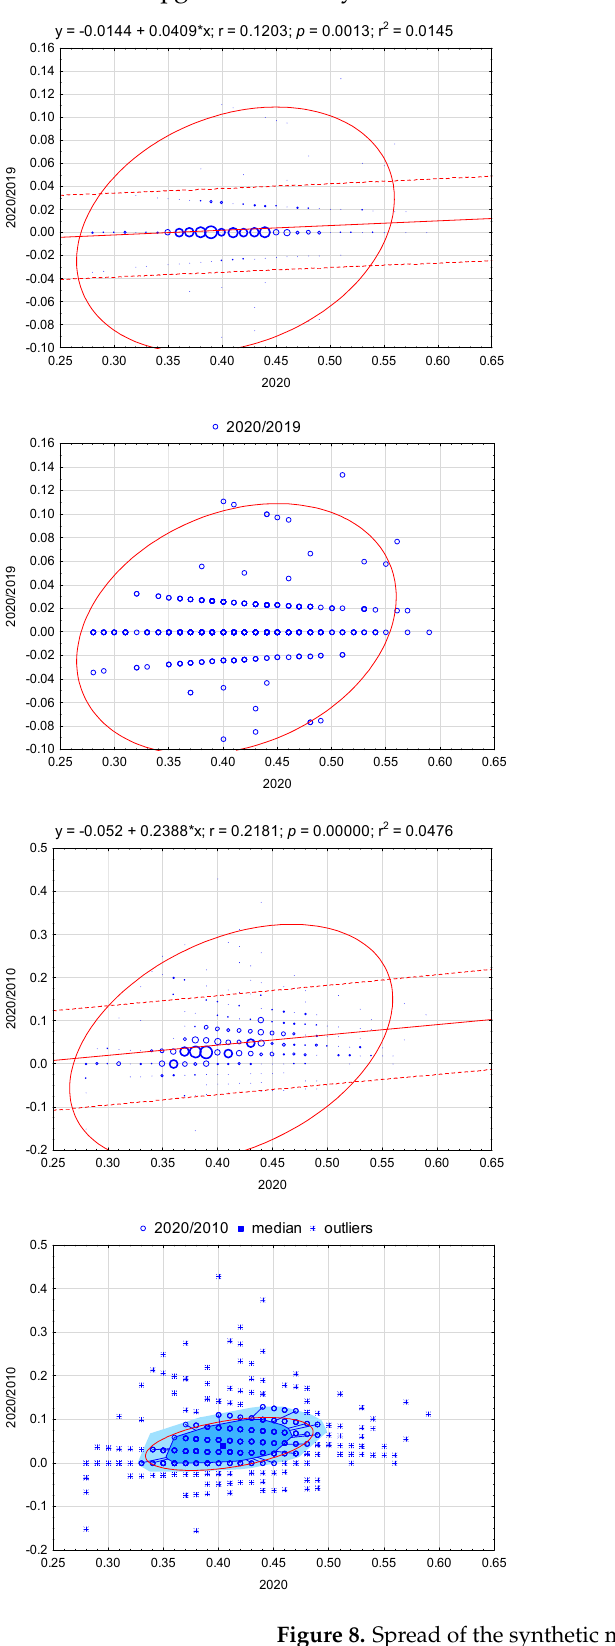
Figure 8. Spread of the synthetic measure of waste management and green economy to the value of changes in communes in Eastern Poland in 2010–2020. Source: own study.